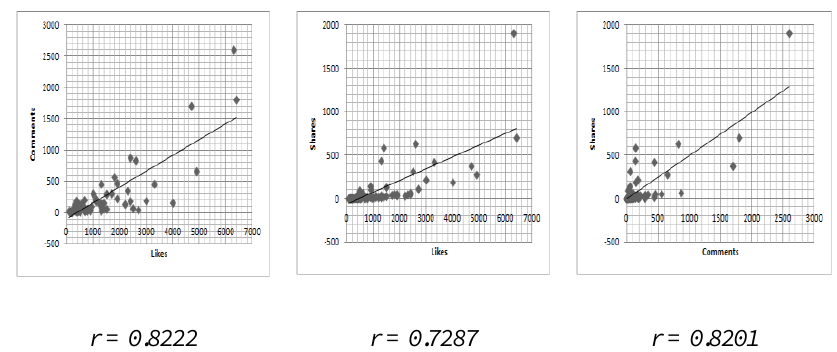
Fig. 12. Correlation Results for Page